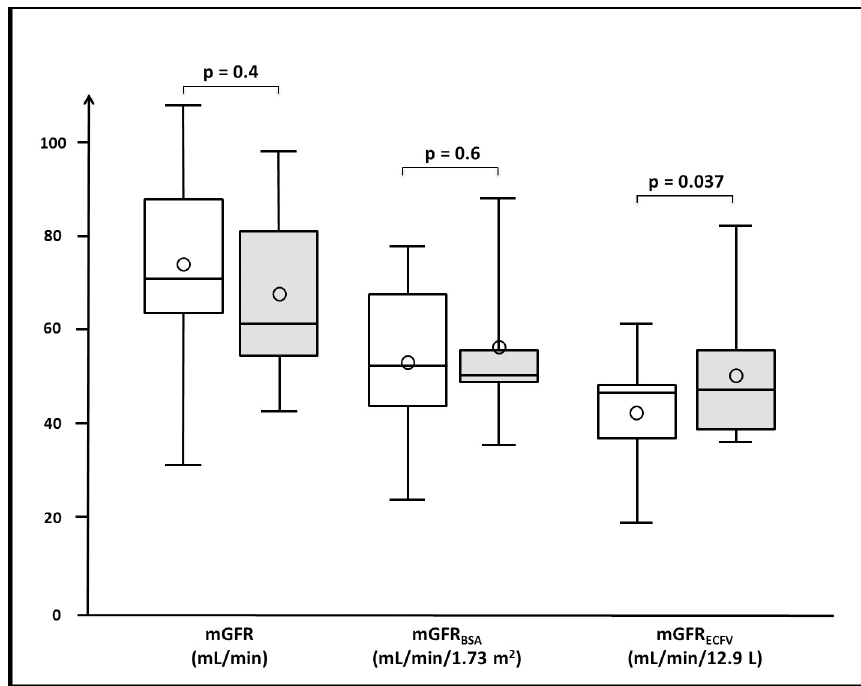
Fig 1. Renal function before (white box) and after (grey box) bariatric surgery (BS). The absolute measured glomerular filtration rate (mGFR, mL/min) and the mGFR scaled to standard body surface area (mGFR BSA , mL/min/ 1.73 m 2 ) are not statistically different before and after BS. The mGFR scaled to standard extracellular fluid volume (mGFR ECFV, mL/min/12.9 L) is significantly higher after BS. Box-plots stand for median and interquartile ranges (25– 75). Circles stand for means, and extreme values are shown with lines. Statistics are obtained with paired Student’s t-